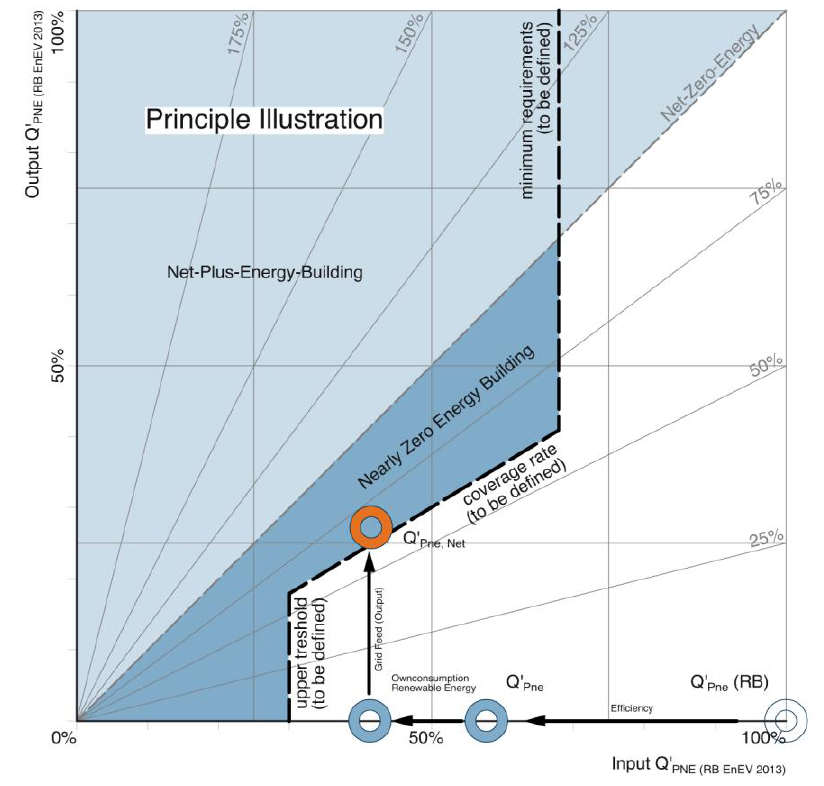
Figure 4. Illustration of the principle for the Nearly Zero Energy Standard based on the representation of an input-output balance (own representation according to [3]); The presentation is a specific requirement relative to the reference building (RB according to EnEV 2013).